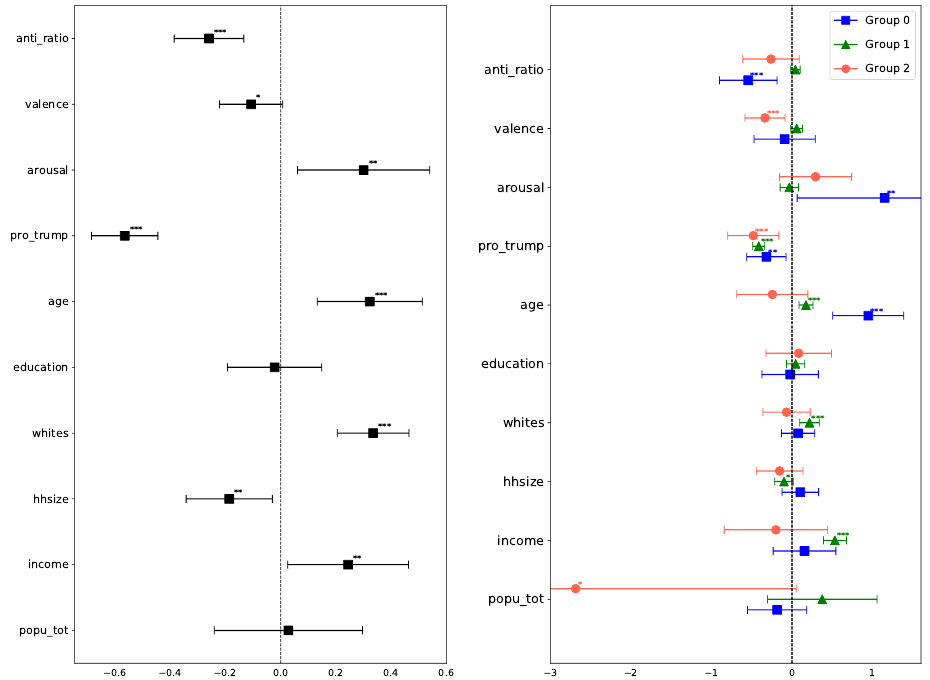
Figure 5. Regression analysis of county COVID-19 vaccination rates. Regression coefficients in the pooled ( left ) and disaggregated ( right ) data. Significance levels of the coefficients are as follows: p < 1% (***), p < 5% (**), p < 10%